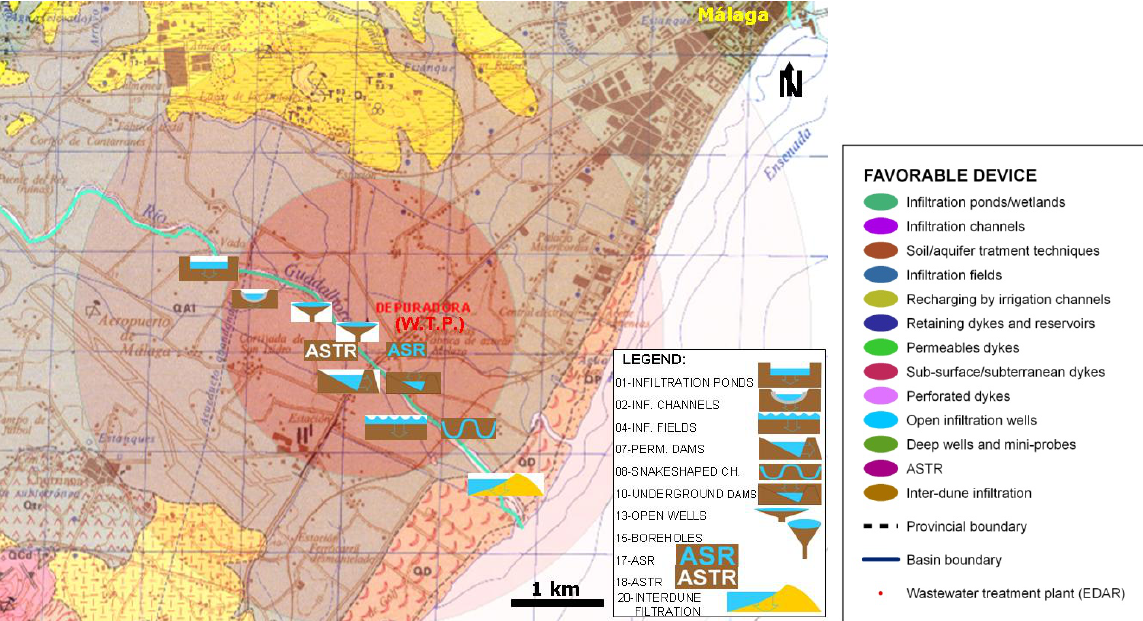
Figure 5. “HydroGeoportal” predicting suitable areas to apply a MAR technique, notably in the Lower Guadalhorce aquifer (Malaga, Spain). The map displays the proposed location of MAR devices obtained through the exposed grades/weights